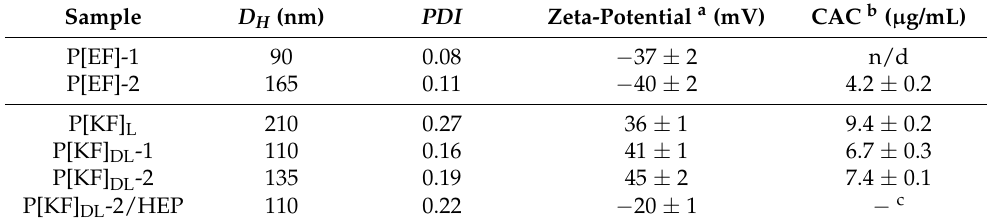
Table 2. The characteristics of nanoparticles formed due to the self-assembly of amphiphilic